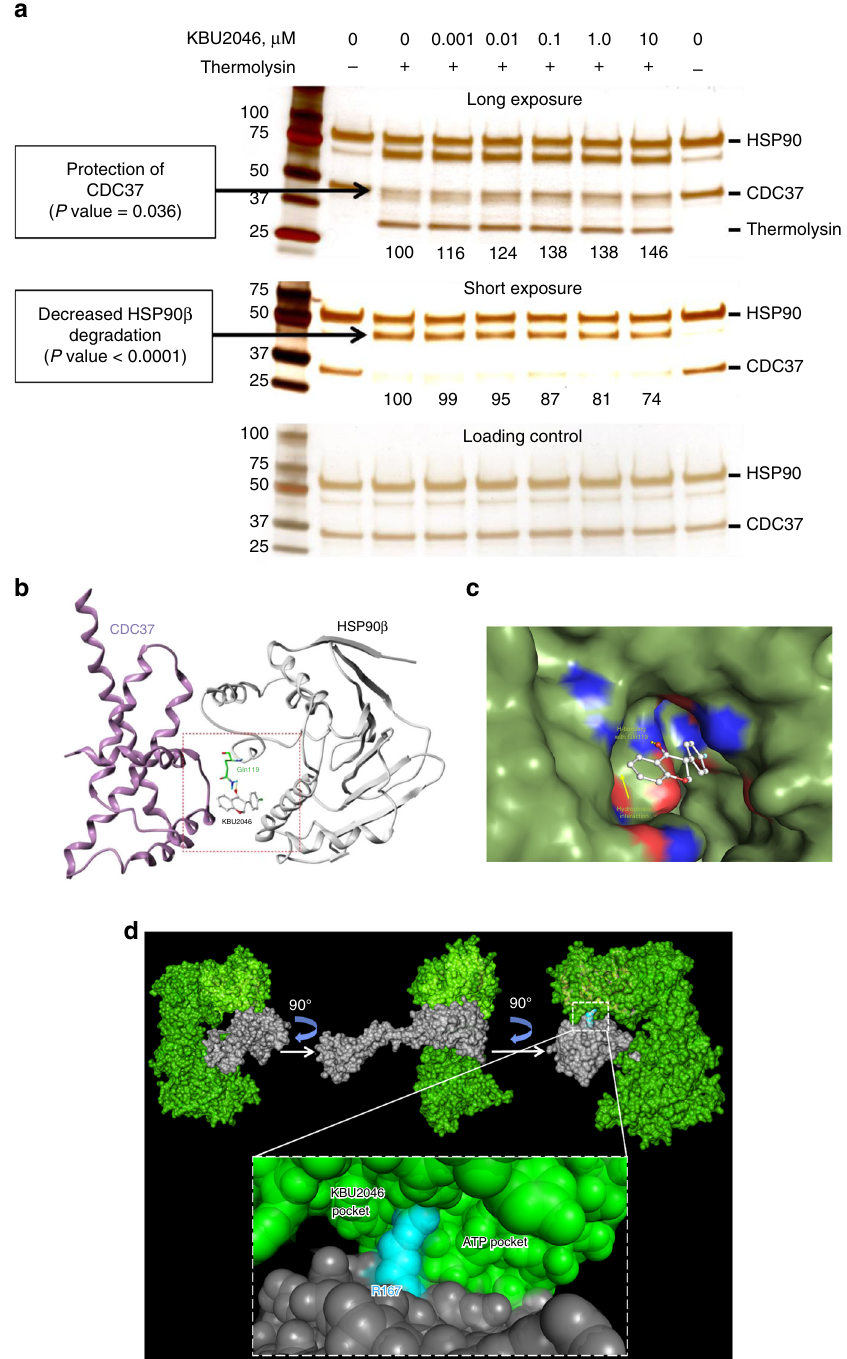
Fig. 5 KBU2046 stabilizes CDC37/HSP90 β heterocomplexes. a KBU2046 stabilizes HSP90 β /CDC37 heterocomplexes in a DARTS assay. Equimolar amounts of HSP90 β and CDC37 protein were pre-incubated with KBU2046, and resultant thermolysin reaction products were detected by silver stain following SDS-PAGE. The mean value (from N = 3 independent experiments) of protein bands indicated by arrows is displayed below each lane, and are expressed as the percentage of untreated control. ANOVA P values for changes in band intensity with concentration are displayed. b In silico model of CDC37 (purple) and HSP90 β (gray) depicting KBU2046 hydrogen bonding with Gln119 of HSP90 β . c Potential surface of the computed ligand binding pocket of the CDC37/HSP90 β model with KBU2046 bound. Atoms within 5 angstroms of KBU2046 are colored by element (carbon, green; nitrogen, blue; oxygen, red). d Potential surface of the whole CDC37/HSP90 β dimer (color code: green — HSP90 β ; gray — CDC37; cyan — Arg167 from CDC37 bisecting the larger pocket and creating a new cleft into which KBU2046